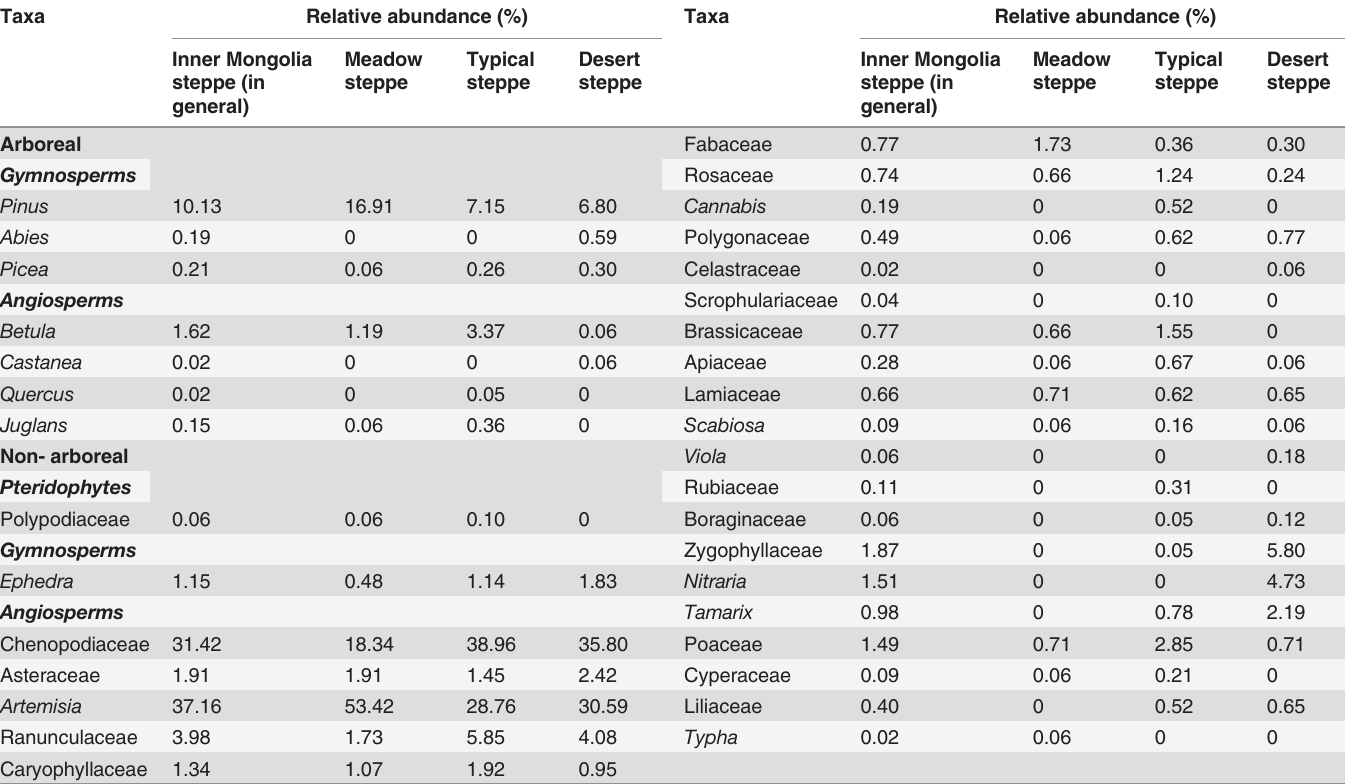
Table 1. The list of the palynomorphs and their relative abundances of 3 steppe types (meadow steppe, typical steppe, and desert steppe) in Inner